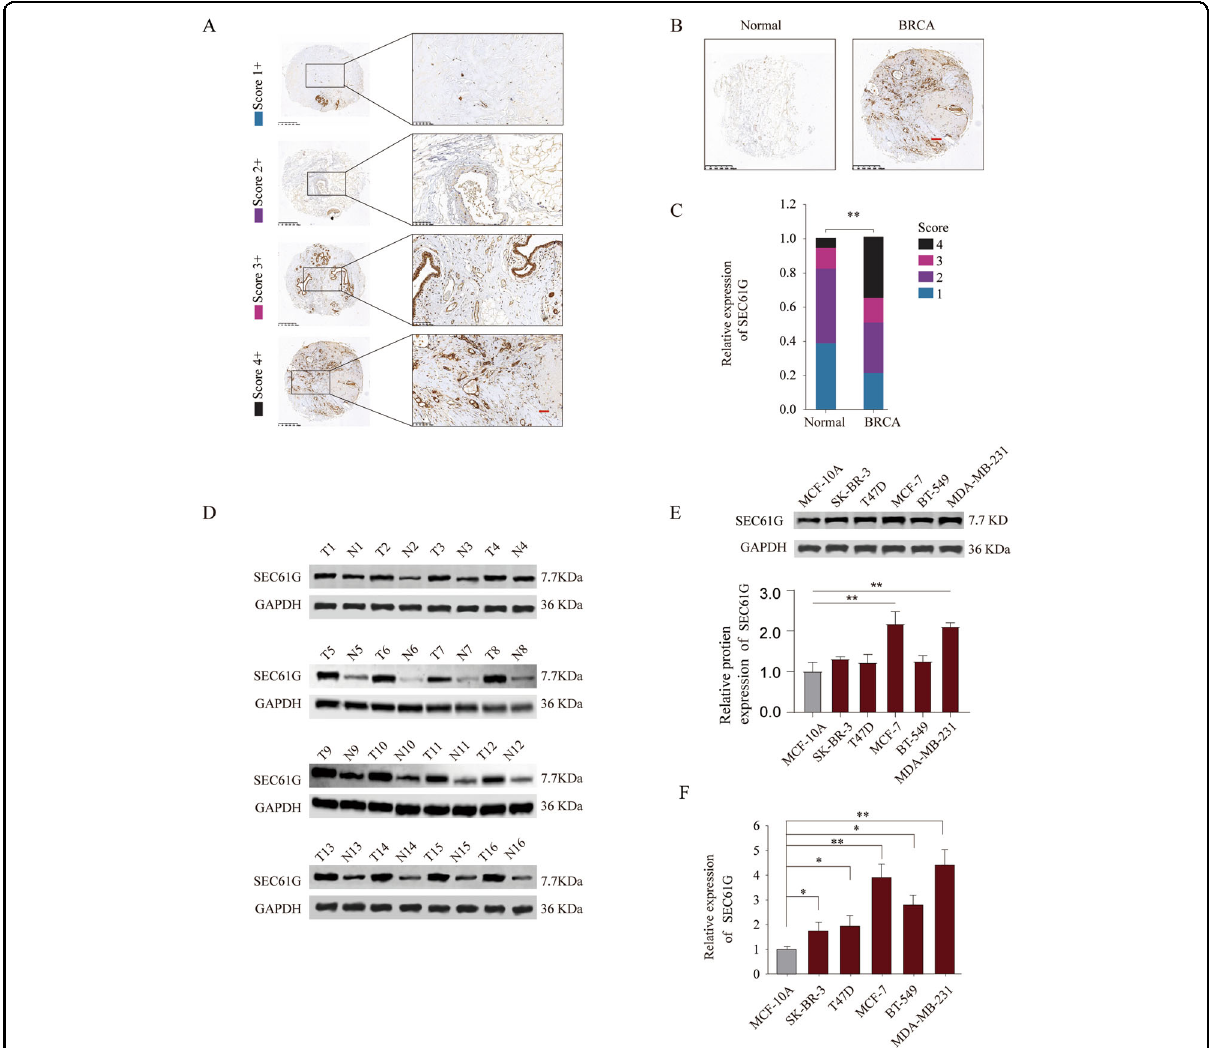
Fig. 2 SEC61G expression is upregulated in breast cancer tissues and cell lines. A Representative SEC16G immunohistochemical (IHC) with different scores based on staining intensity in breast cancer tissue microarray. B Representative SEC61G IHC staining in breast cancer tissues and adjacent non-tumor normal tissues. C Comparison of IHC staining score distributions between breast cancer tissues and adjacent non-tumor normal tissues. D The protein expression of SEC61G in 16-paired breast cancer tissues (T) and adjacent normal tissues (N) was assessed by western blot. E , F The protein and mRNA expression of SEC61G in normal breast epithelial cell MCF-10A and breast cancer cell lines (SK-BR-3, T47D, MCF-7, BR-549, and MDA-MB-231) was analyzed by western blot or qRT-PCR. * P < 0.05, ** P <